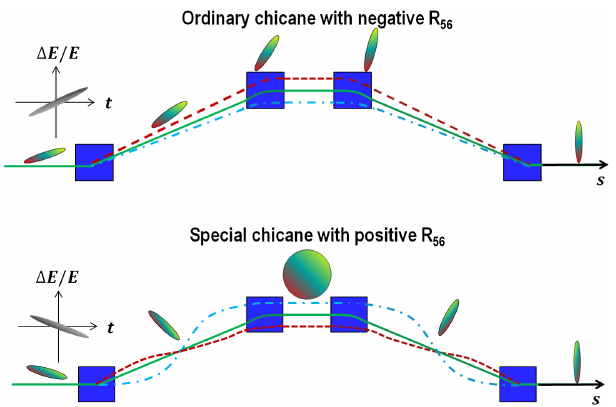
FIG. 3. Schematic layout of the ordinary negative R 56 chicane (top plot) and the special positive R 56 chicane (bottom plot). The blue, green, and red curves represent the trajectories of high energy particle, center energy particle, and low energy particle,